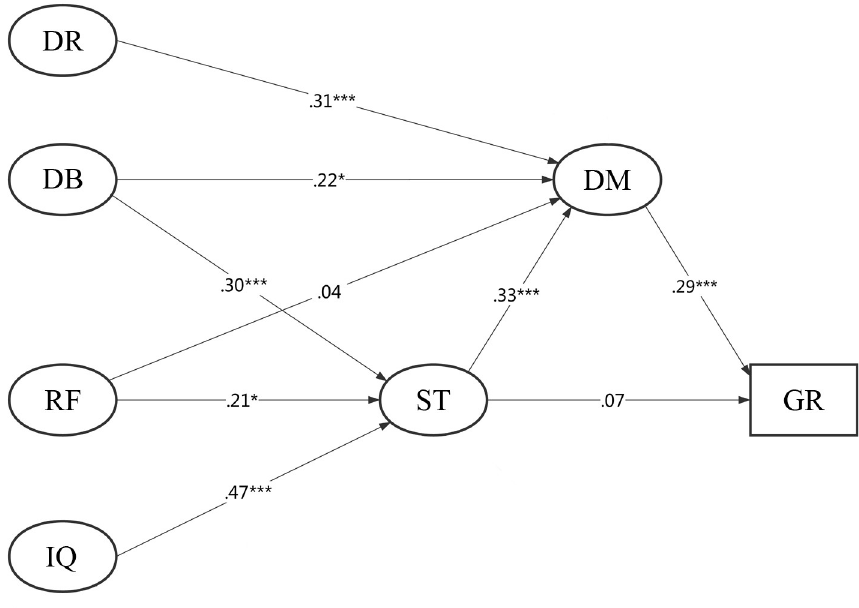
Fig 2. Path coefficients of the research model after modification by cutting redundant items. ( � p < .05; �� p < .05, p < .01; ��� p < 0.001).